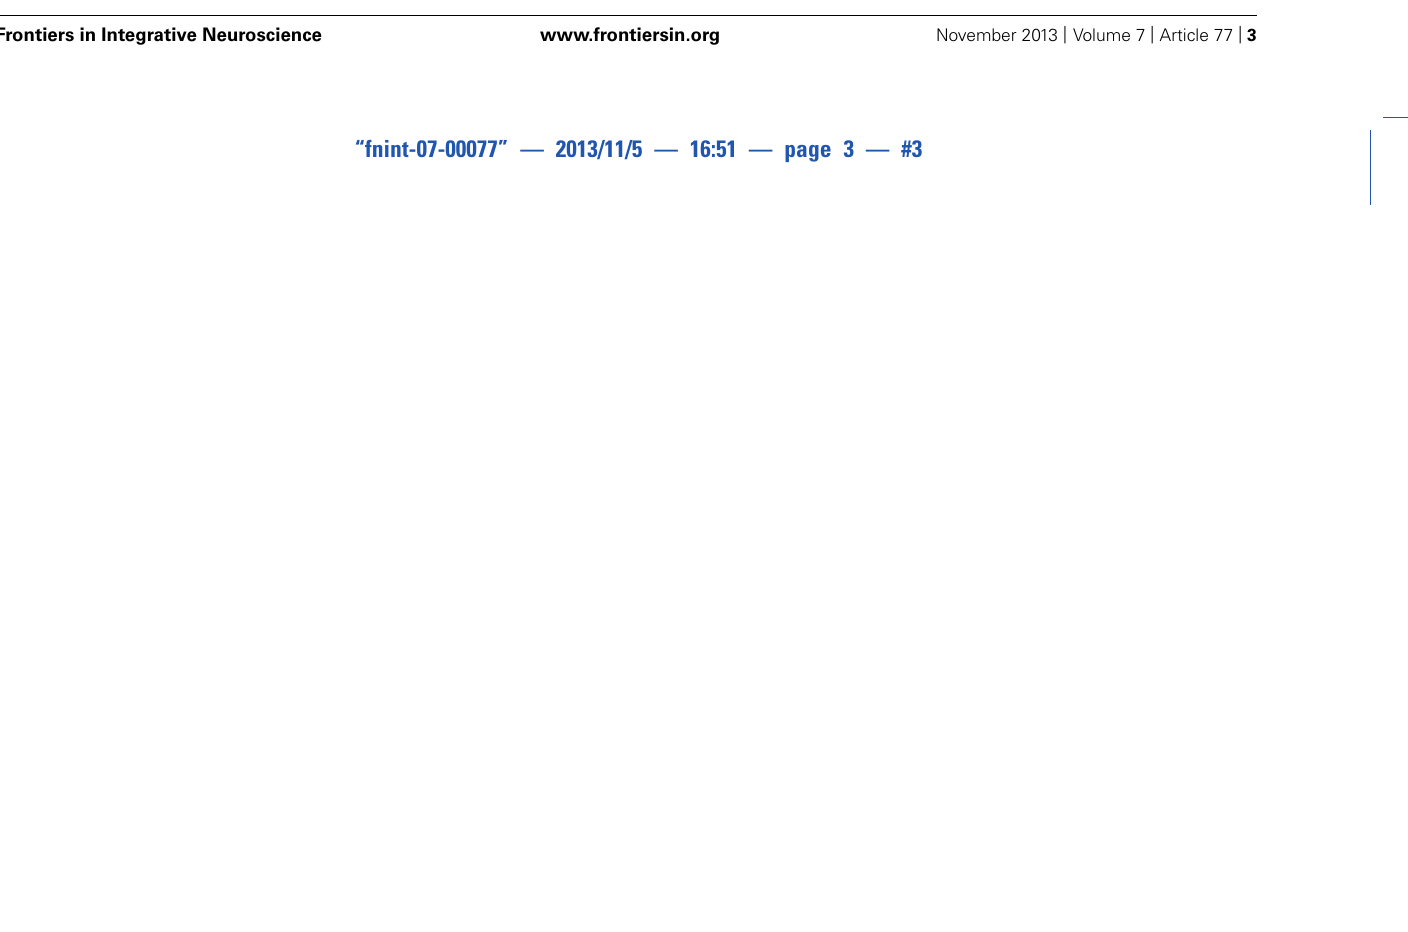
FIGURE 1 | Schematic representation of the rapid serial visual presentation (RSVP) trial sequence and visual images. (A) Target 1 (T1) images (purple object; watch, mug, t -shirt, or box). (B) Target 2 (T2) images; orange, rose, lemon or mint (C) Example images for OrangeT2.There were seven exemplars of eachT2, comprising photos of the same object taken from different angles. (D) Example RSVP sequence.The fixation cross was